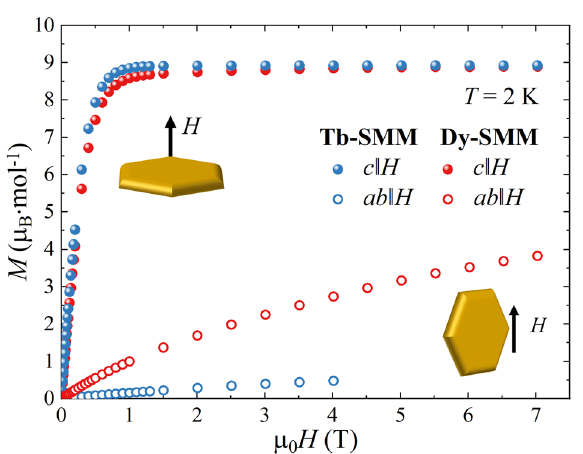
Figure 2. The isothermal magnetization of Tb-SMM and Dy-SMM at T = 2.0 K measured for ab ∥ H and c ∥ H orientations in the applied field range µ 0 H = 0–7 T, except for Tb-SMM in ab ∥ H , for which the highest field was µ 0 H = 4 T (see “Materials and methods” section). Inset pictures present the orientation of the sample regarding the external field H